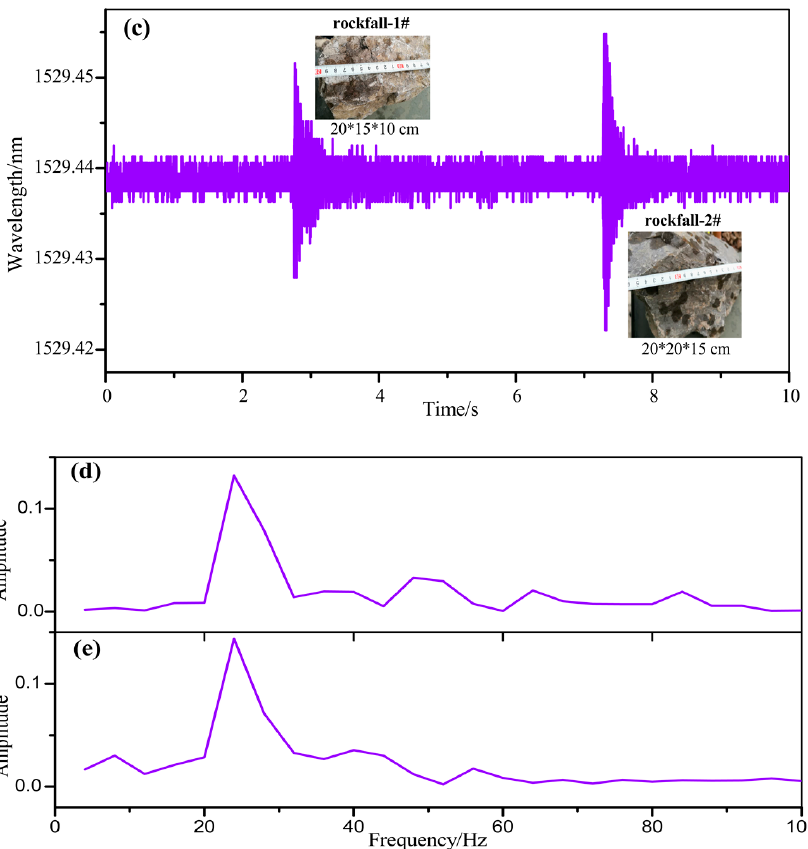
Figure 14. Measurement of rockfall vibration: ( a ) a schematic diagram of the experiment; ( b ) a photo of the fiber Bragg grating (FBG) accelerometer; ( c ) the vibration signal measured in the time domain; ( d ) the frequency response of rockfall-1#; ( e ) the frequency response of rockfall-2#.